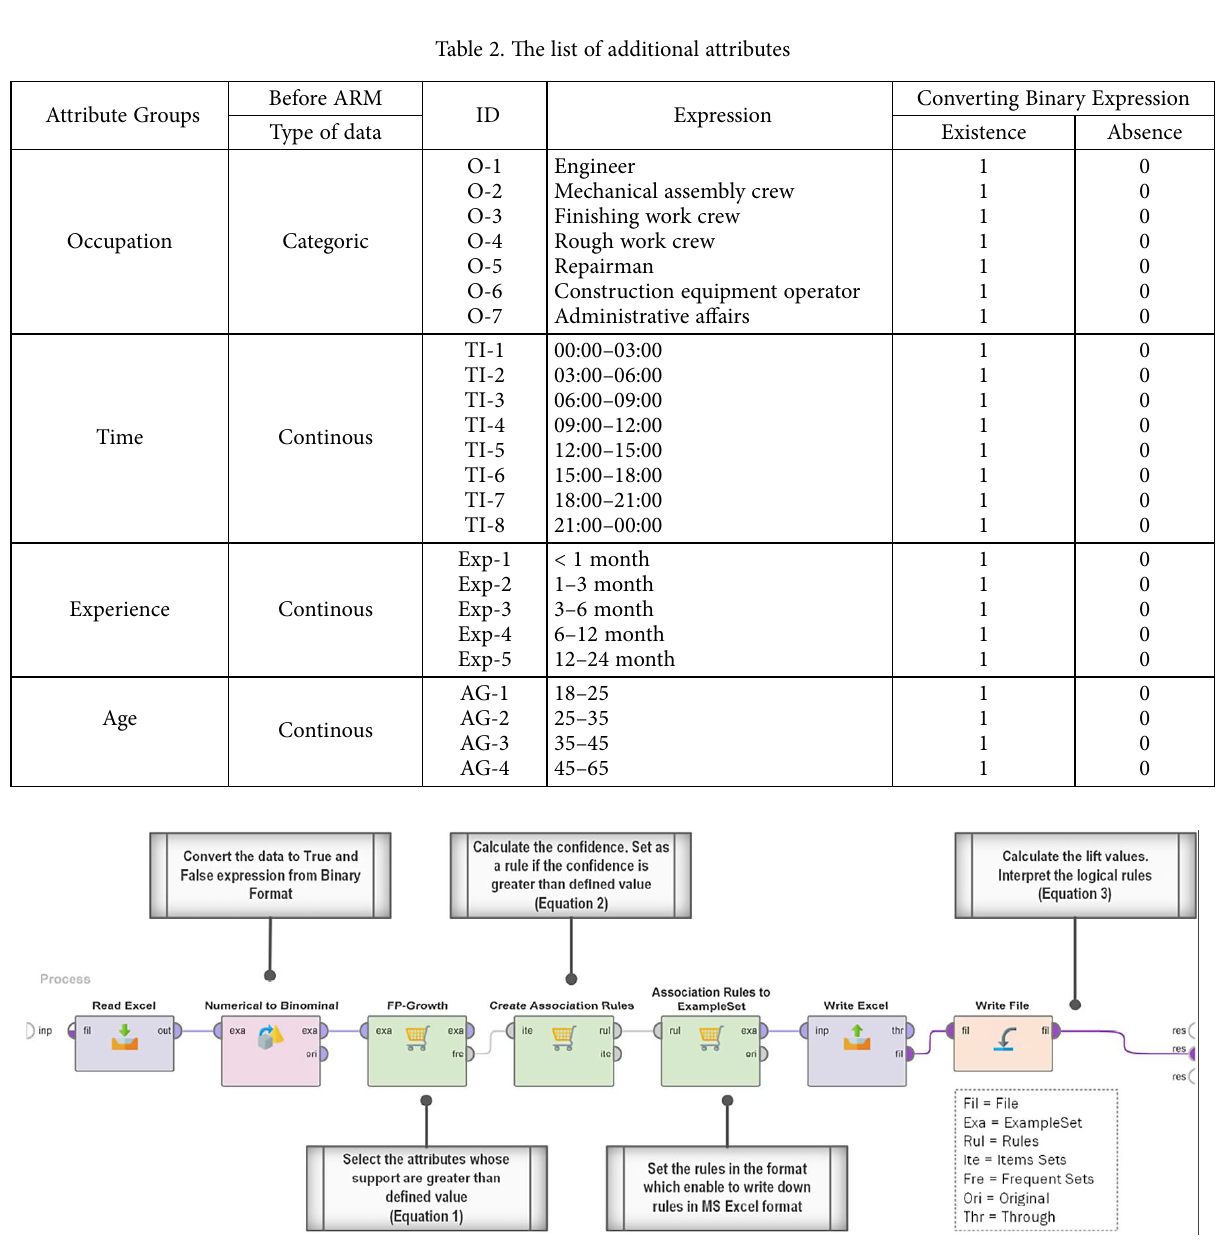
Figure 3. Representation of ARM